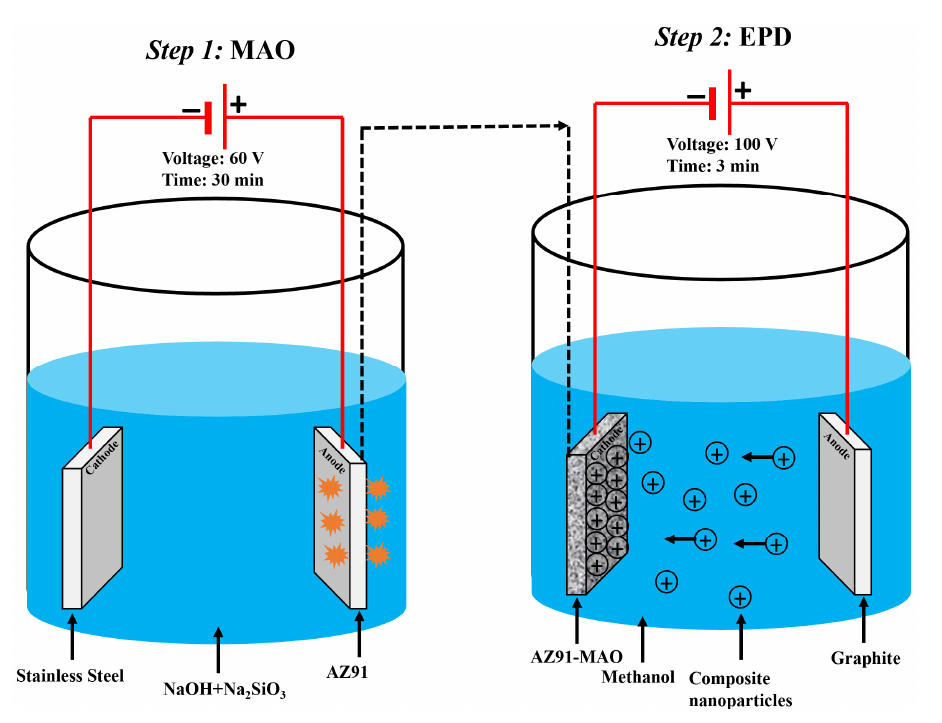
Figure 1. Schematic representation of MAO-EPD coating method: In step 1, i.e., MAO, a power supply was used; an AZ91 sample was used as the anode and a stainless-steel plate as the cathode electrodes; a mixture of NaOH (200 g/L) and Na 2 SiO 3 (200 g/L) were also used as the electrolyte solution. MAO was performed in the voltage of 60 V for 30 min. In step 2, i.e., EPD, an AZ91 sample was used as the cathode and a graphite rod as the anode electrode. A suspension of nanocomposite particles at a concentration of 10 g particles/100 mL methanol was also used as the electrolyte. EPD was then performed under a voltage of 100 V for 3 min at room temperature.